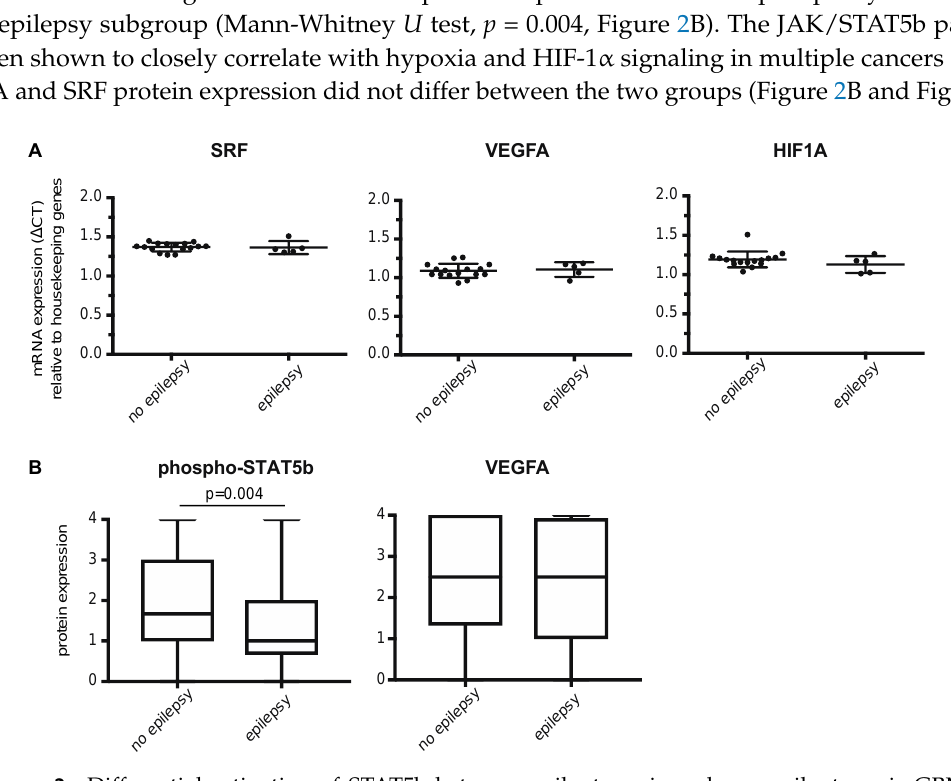
Figure 2. Differential activation of STAT5b between epileptogenic and non-epileptogenic GBMs. ( A ) qPCR experiments showing mRNA expression ( ∆ CT) of SRF, VEGFA and HIF1A in GBM patients with epilepsy ( n = 5) and without epilepsy ( n = 16). Graphs show mean ± SD and expression values per patient. Expression values were normalized to the average of 3 housekeeping genes (ACTB, GAPDH, GUSB). There was no significant difference in mRNA expression between epilepsy and non-epilepsy samples (independent samples t -test, SRF: p = 0.9, VEGFA: p = 0.76, HIF1A: p = 0.23). ( B ) Protein expression of phosphorylated STAT5b and VEGFA on GBM samples included on a tissue microarray. STAT5b expression was significantly lower in patients that presented with epilepsy compared to GBM patients with other presenting symptoms ( n = 265, Mann Whitney U test, p = 0.004). VEGFA expression did not differ between the groups ( n = 275, Mann Whitney U test, p =